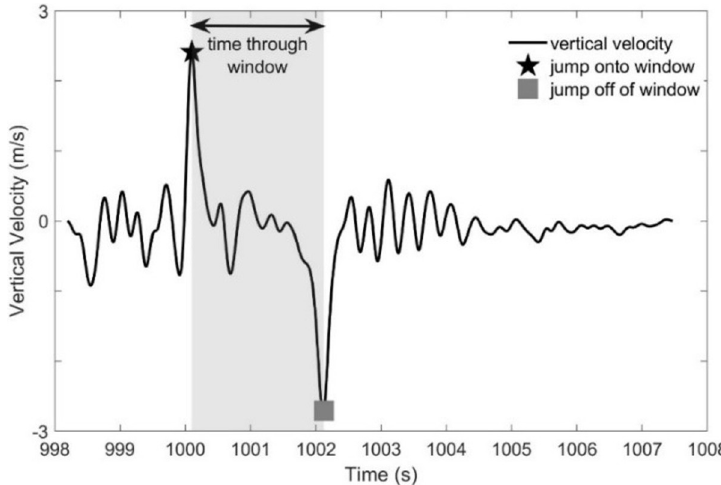
Fig 7. Drift-corrected vertical velocity of the sacrum IMU for a sample trial. Maximum vertical velocity (black star) corresponds to the participant jumping up onto the window. Minimum vertical velocity (gray square) corresponds to the participant jumping down off of the window. Time through the window is the interval between these